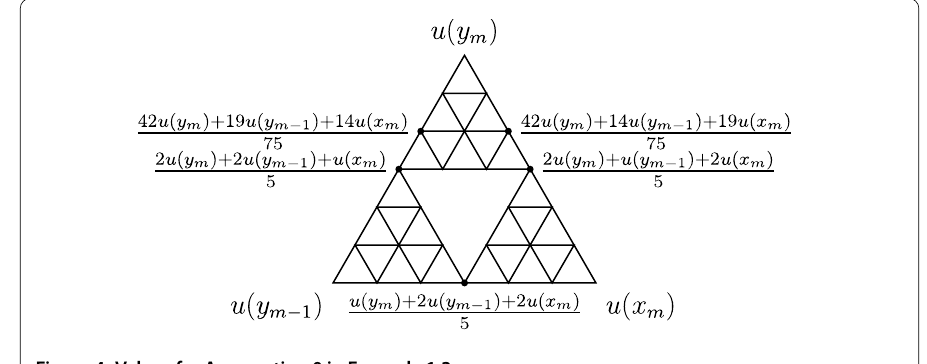
Figure 4 Values for Assumption 0 in Example